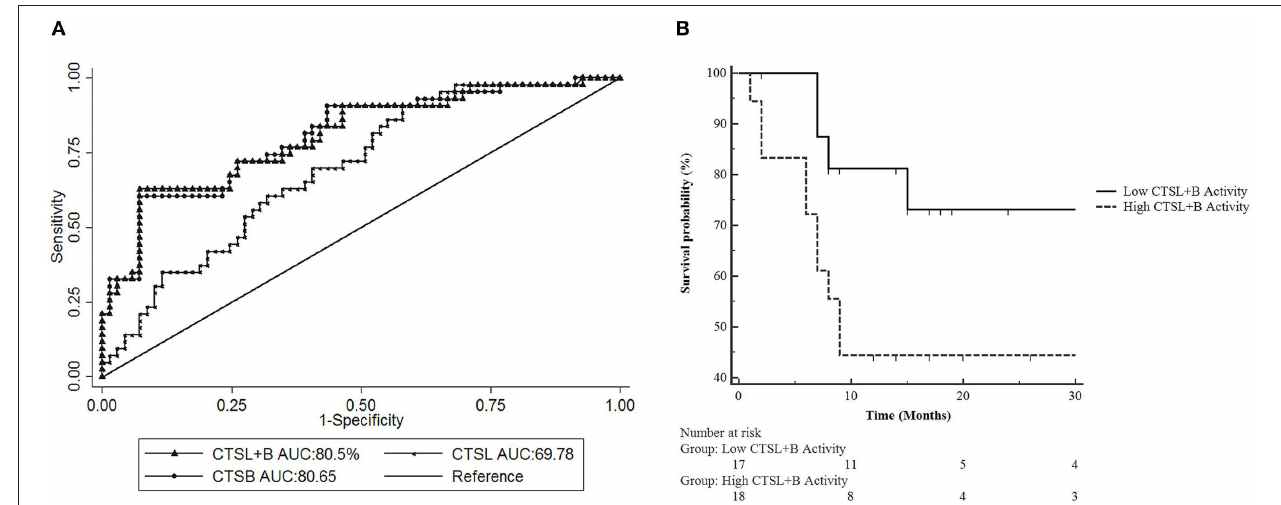
FIGURE 3 | Receiver Operative Characteristic (ROC) Curve analysis of CTSL + B, CTSL, and CTSB in GBC. (A) ROC curve analysis revealed excellent diagnostic performance of CTSL + B and CTSB with an AUC value of 80% in GBC. Sensitivity = True positive fraction; 1-Specificity = False-positive fraction. (B) Prognostic significance of cysteine cathepsins in GBC. Kaplan Meier analysis revealed a strong correlation between higher CTSL + B activity and poor overall survival in GBC patients ( p = 0.0493).